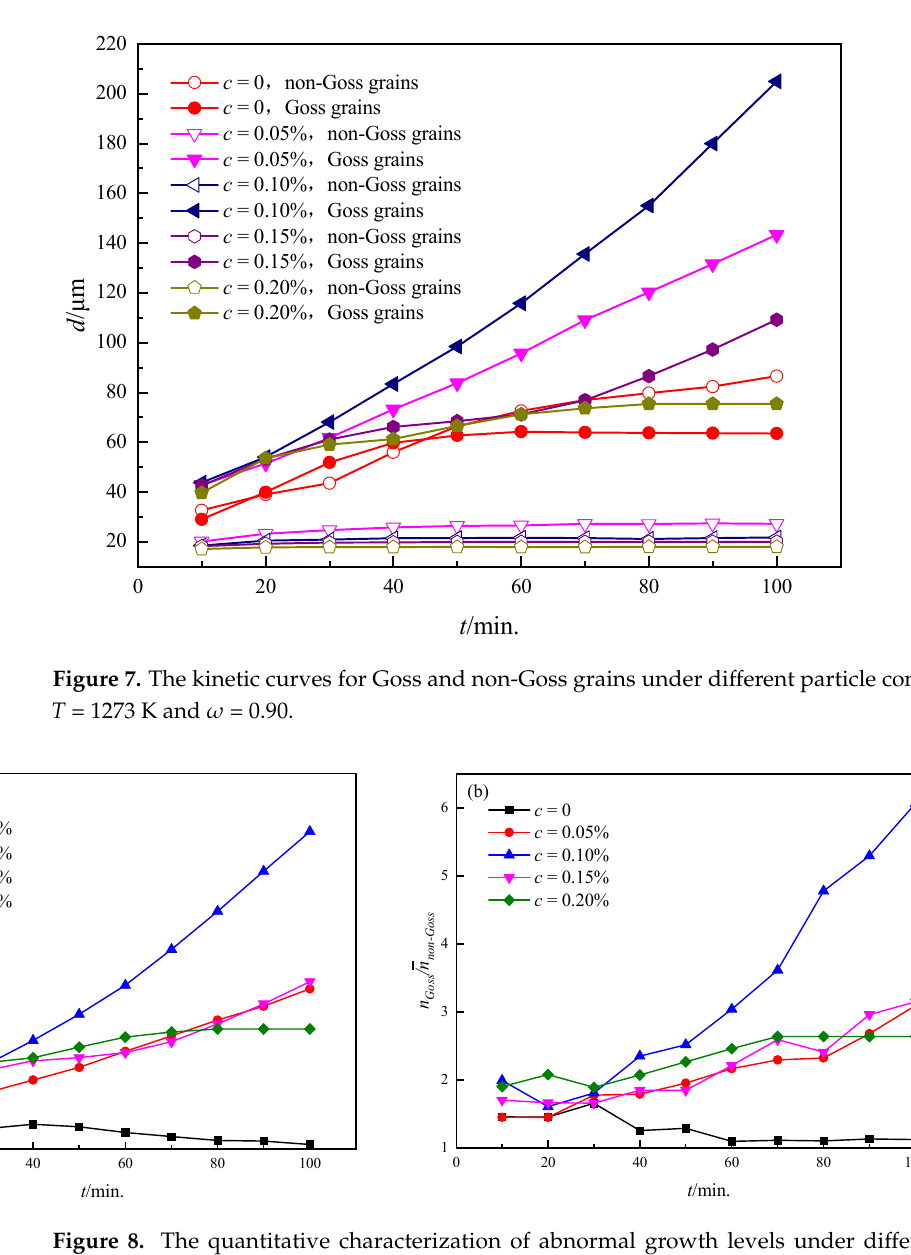
Figure 8. The quantitative characterization of abnormal growth levels under different particle con- tents: ( a ) the size ratio of Goss grains to non-Goss grains; ( b ) the side ratio of Goss grains to non- Goss grains.